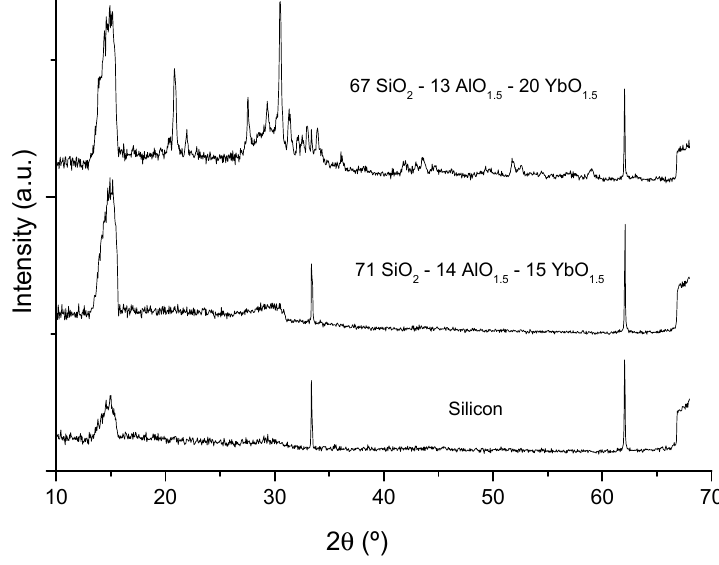
Figure 2. X-ray diffraction patterns of silicon and two aluminosilicate films with 15 and 20 mol% YbO 1.5 , heat treated at 1100 °C.